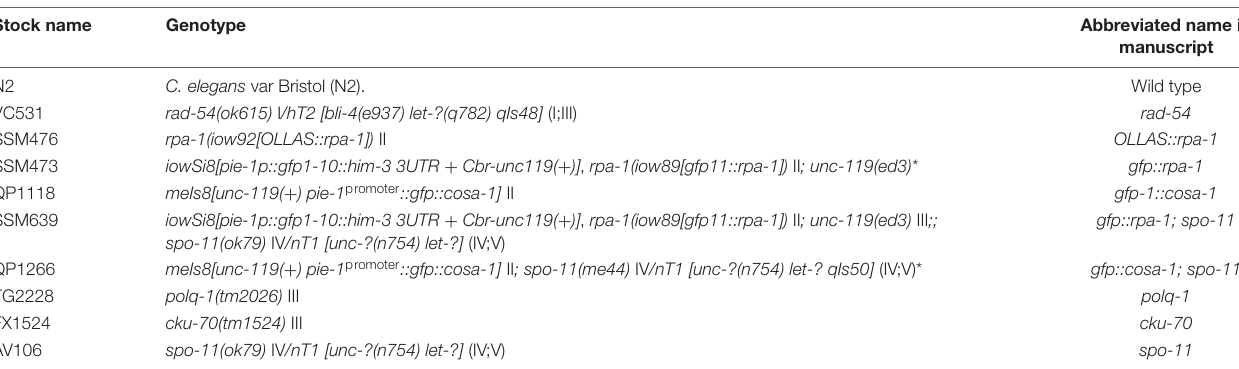
TABLE 1 | C. elegans stocks used in this